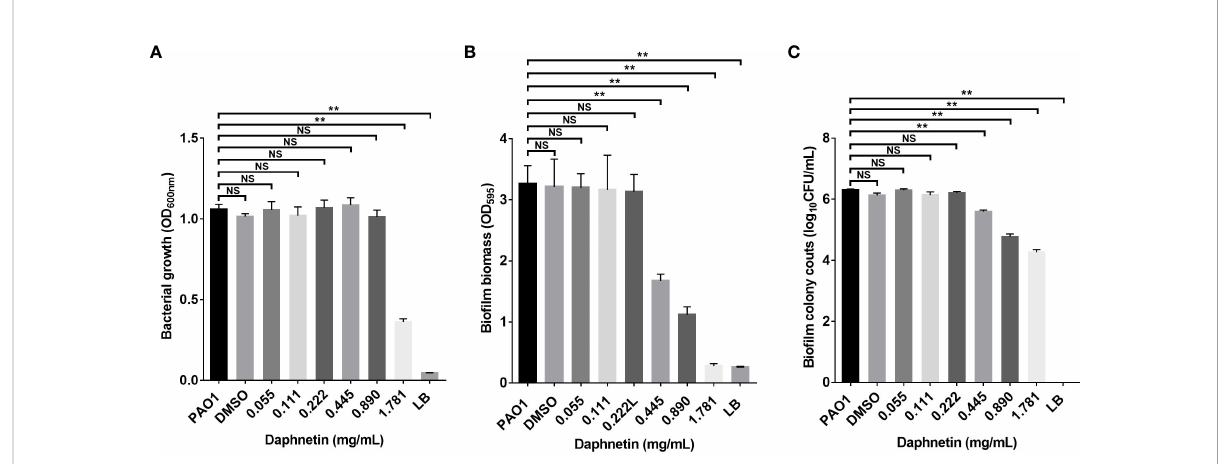
FIGURE 3 The bio fi lm inhibition effect of daphnetin (DAP) against P. aeruginosa . Bacterial suspensions were seeded in 96-well plates exposed to different concentrations of DAP (0.055, 0.111, 0.222, 0.445, 0.890, and 1.781 mg/mL) for 20 h, and bio fi lm mass formation and bacterial counts were quanti fi ed in triplicate. (A) Planktonic bacterial growth evaluation. (B) Crystal violet staining. (C) Bio fi lm bacterial counts. Results are represented as the mean ± standard deviation (SD). NS indicates P-values >0.05 and ** indicate P-values